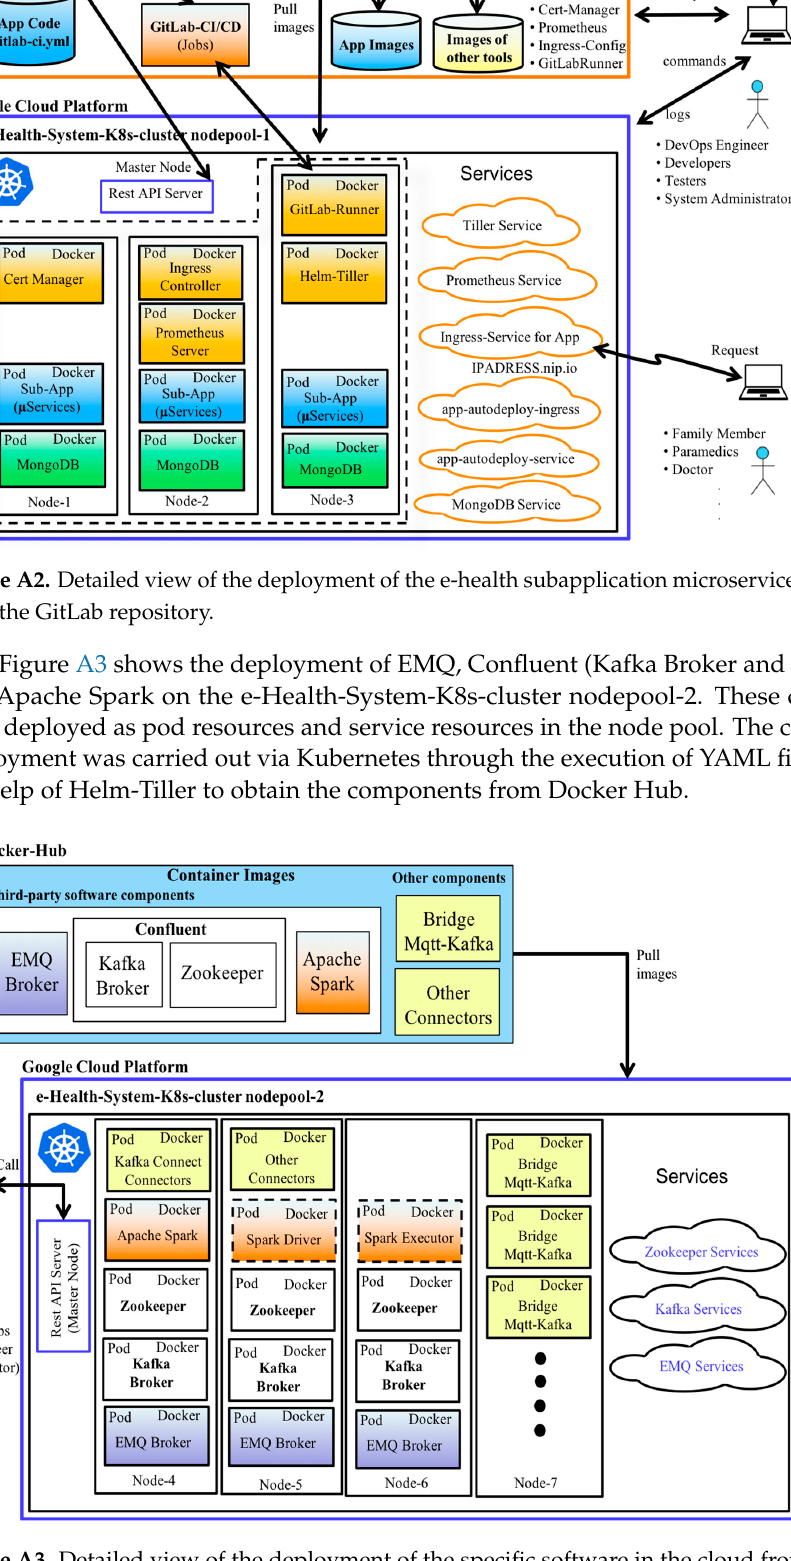
Figure A3. Detailed view of the deployment of the specific software in the cloud from the Docker Hub repository.